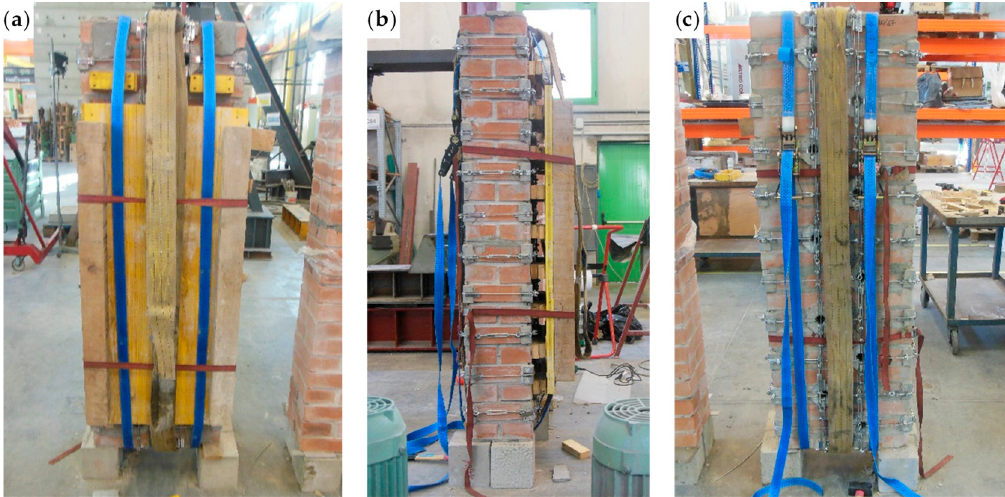
Figure 44. Slinging of Specimen W5, used to allow handling and overturning of the specimen by means of the girder crane: ( a ) front view; ( b ) viewed from the left; and ( c ) back view.